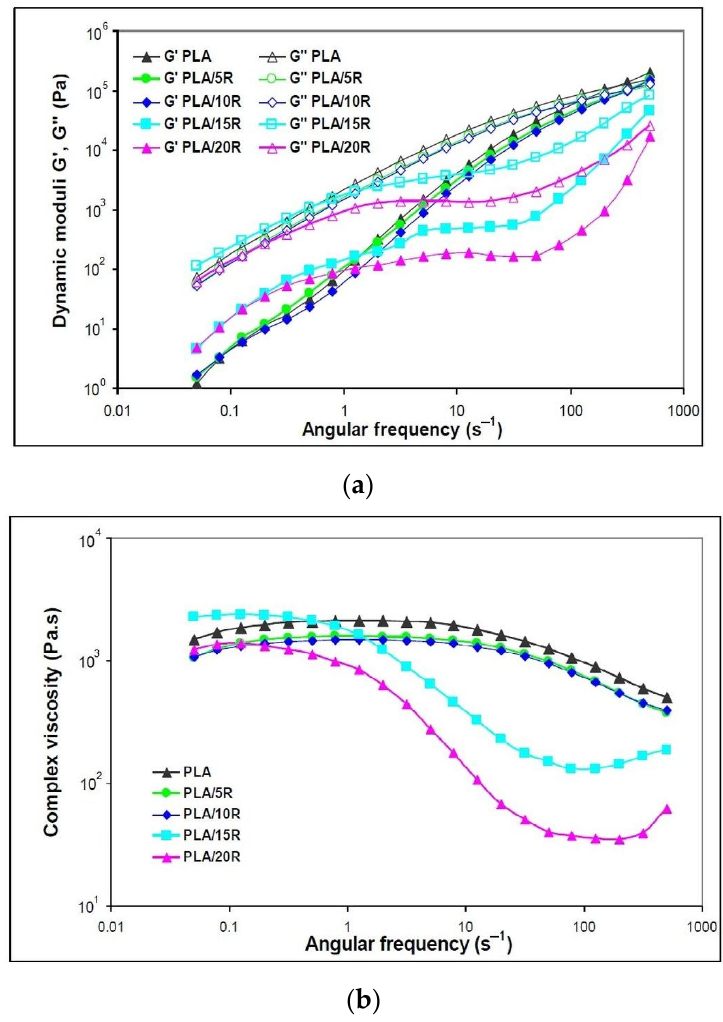
Figure 6. Variation of ( a ) dynamic moduli (storage moduli and loss moduli) and ( b ) complex viscosity function of angular frequency for neat PLA and blends plasticized with natural castor oil.